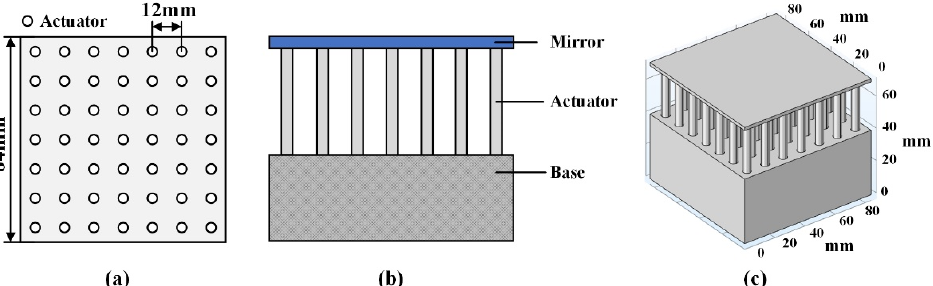
Figure 1. Schematic diagrams of the DM. ( a ) Actuator distribution, ( b ) side view of structure and ( c ) COMSOL model of the DM. Table 2. Structural parameters of the DM.